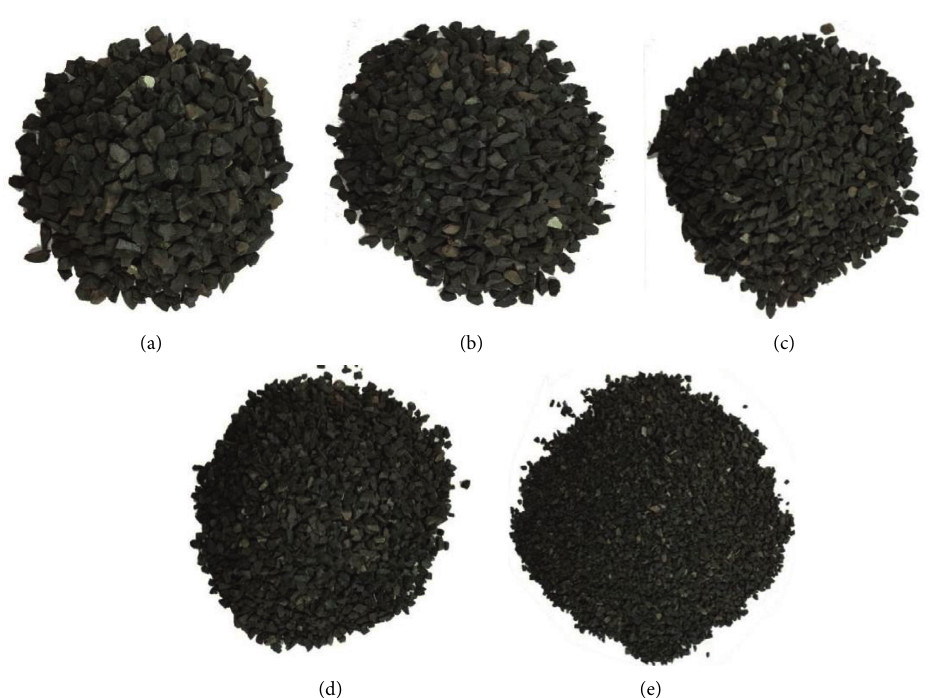
Figure 1: Classification of particle size: (a) 20.0 ∼ 25.0 mm. (b) 15.0 ∼ 20.0 mm. (c) 10.0 ∼ 15.0mm. (d) 5.0 ∼ 10.0mm. (e) 2.5 ∼